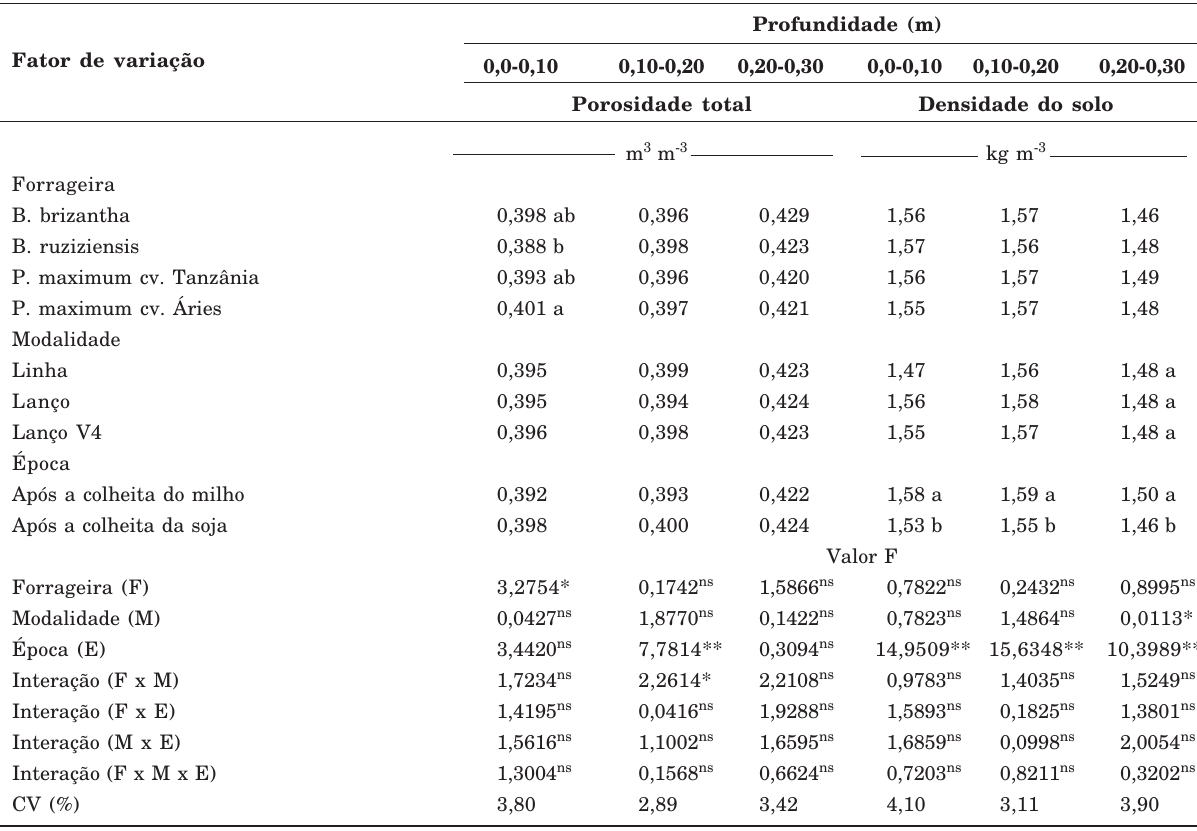
Quadro 7. Valores médios de porosidade total e densidade do solo avaliados nas camadas de 0,0-0,10,